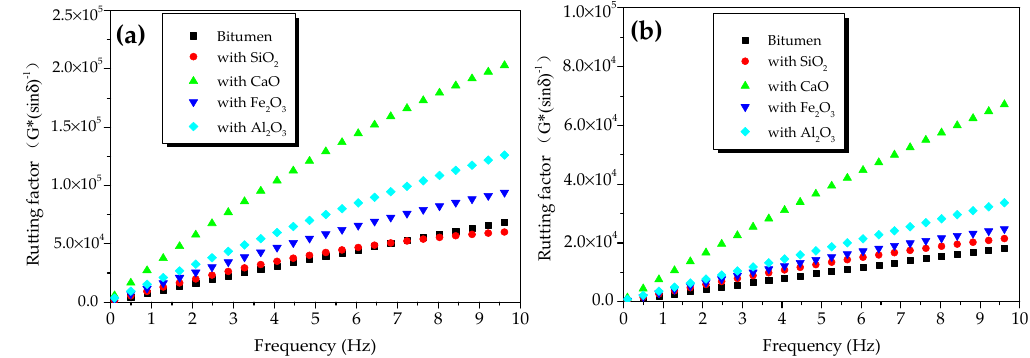
Figure 6. Rutting factors of oxide-modified bitumen mixtures at different temperatures: ( a ) 45 °C and ( b ) 55 °C.